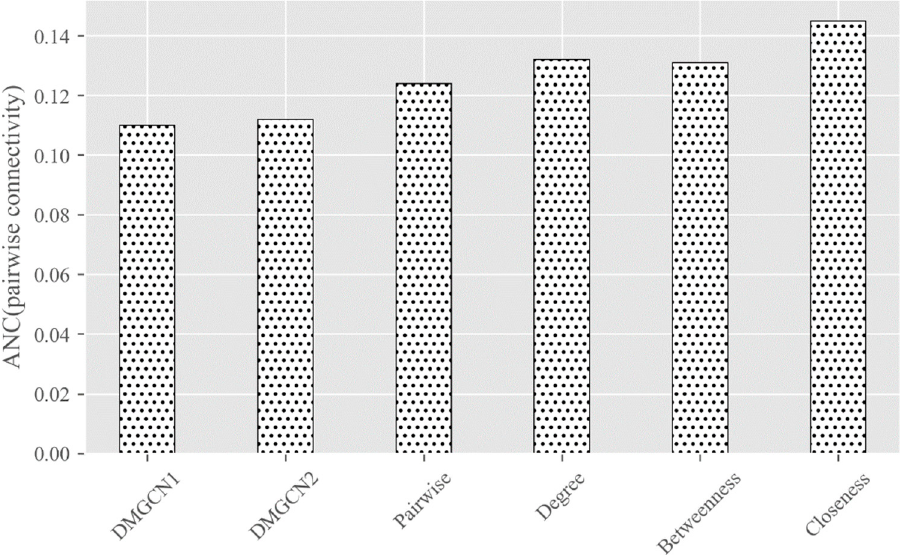
Figure 6. Performance comparison between the proposed method (DMGCN) and other heuristic methods in the 9/11 criminal network. The x -axis represents ANC results from pairwise connectivity. DMGCN1 refers to the model trained by small-world networks, and DMGCN2 refers to the model trained by scale-free networks.